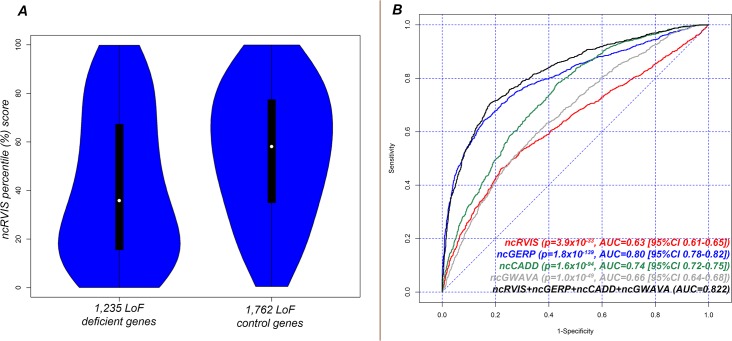
(A) Distribution of ncRVIS scores for the 1,235 loss-of-function deficient genes (left) compared to the 1,762 loss-of-function control genes (right). Median 37.95% vs. 58.09%; Mann-Whitney U test, p = 6.6x10-34. (B) Receiver operating characteristic (ROC) curves measuring the ability of RVIS, ncRVIS, pcGERP and ncGERP to discriminate between loss-of-function deficient and loss-of-function control genes.To obtain the presented levels of significance in (B), we used a logistic regression model to regress loss-of-function deficient or control gene status for the combined 2,997 genes on each of the four genic scores.